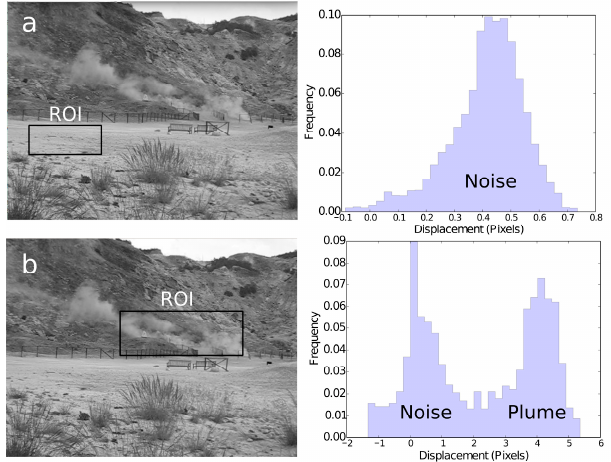
Figure 4. Image frame recorded at position A (Figure 1b,c) looking at the main vents with marked ROI and the corresponding normalized histograms (distributions of vertical displacements ∆ y l ) for a single frame pair (time step 0.5 s) for ( a ) a static foreground and ( b ) for the plume. Note that the bin width in the plots was chosen for display purposes and does not reflect the actual resolution of the